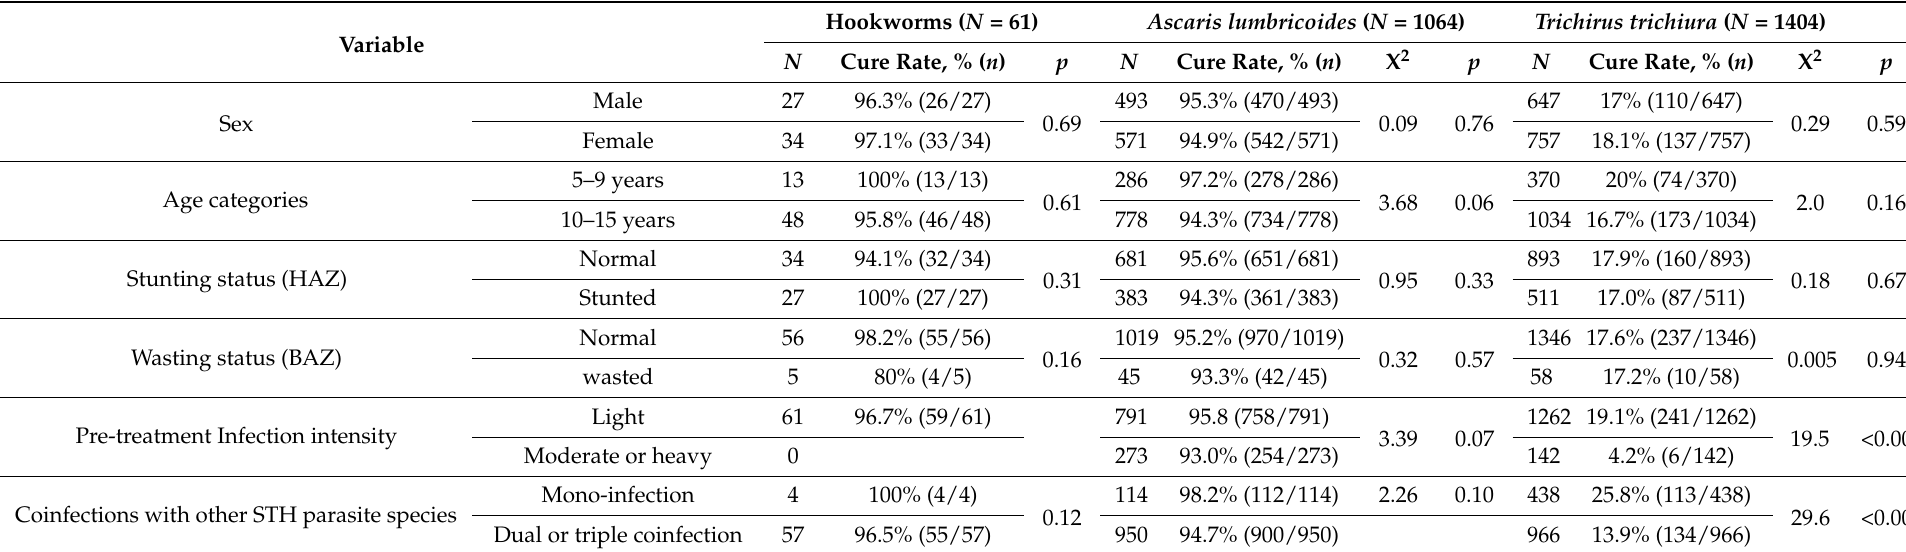
Table 4. Factors associated with cure rates of albendazole against hookworm A. lumbricoides and T. Trichiura